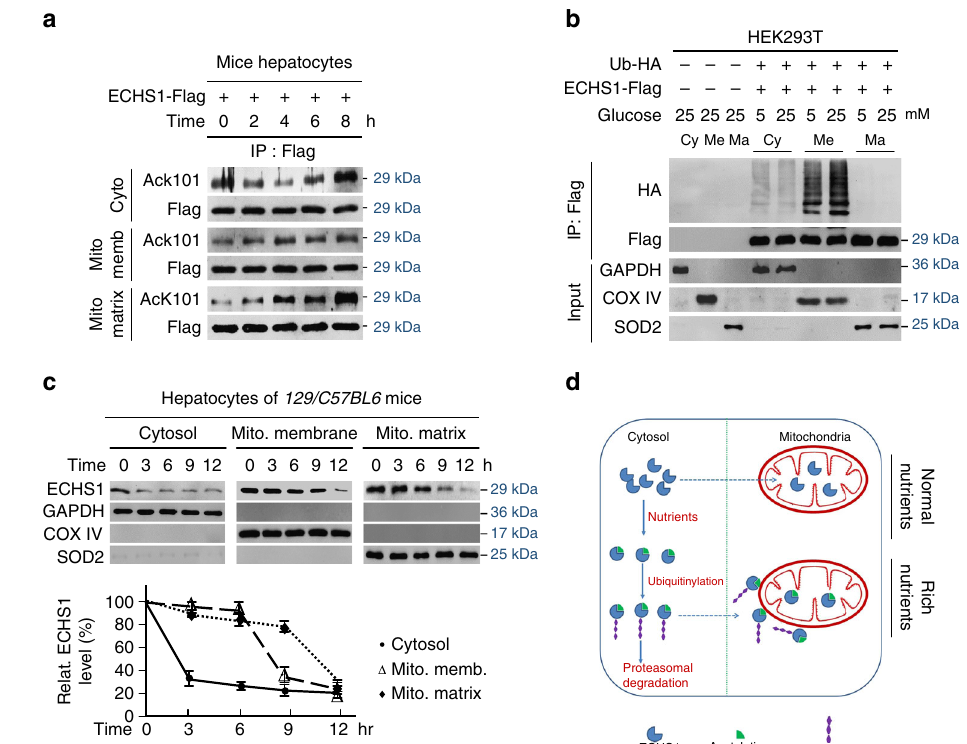
Fig. 6 K101 acetylation inhibits ECHS1 mitochondria translocation. a The K101 acetylation levels of ECHS1 in the cytosol, mitochondria membrane, and mitochondria matrix were detected after mouse primary hepatocytes were exposed to 25 mM glucose for 0, 2, 4, 6, and 8 h. b Flag-tagged ECHS1 was co- expressed with HA-tagged ubiquitin in HEK293T cells. ECHS1 ubiquitination levels in the cytosol, mitochondria membrane, and mitochondria matrix were detected under low and high glucose treatment for 4 h. GAPDH, COX IV and SOD2 were used as markers of cytosol, mitochondria membrane and mitochondria matrix, respectively. c ECHS1 levels in the cytosol, mitochondria membrane, and mitochondria matrix were analyzed ( n = 3) after cells were exposed to 25 mM glucose for 3, 6, 9, and 12 h. Representative western blots are presented. All levels were normalized to those of cells at time 0 and the average relative levels were quanti fi ed ( bottom ). d Schematic diagram of ECHS1 regulation by nutrients. Nutrient-induced acetylation inactivates ECHS1 and induces ubiquitination of ECHS1 that blocks ECHS1 mitochondrial translocation and promotes ECHS1 degradation. These effects synergistically